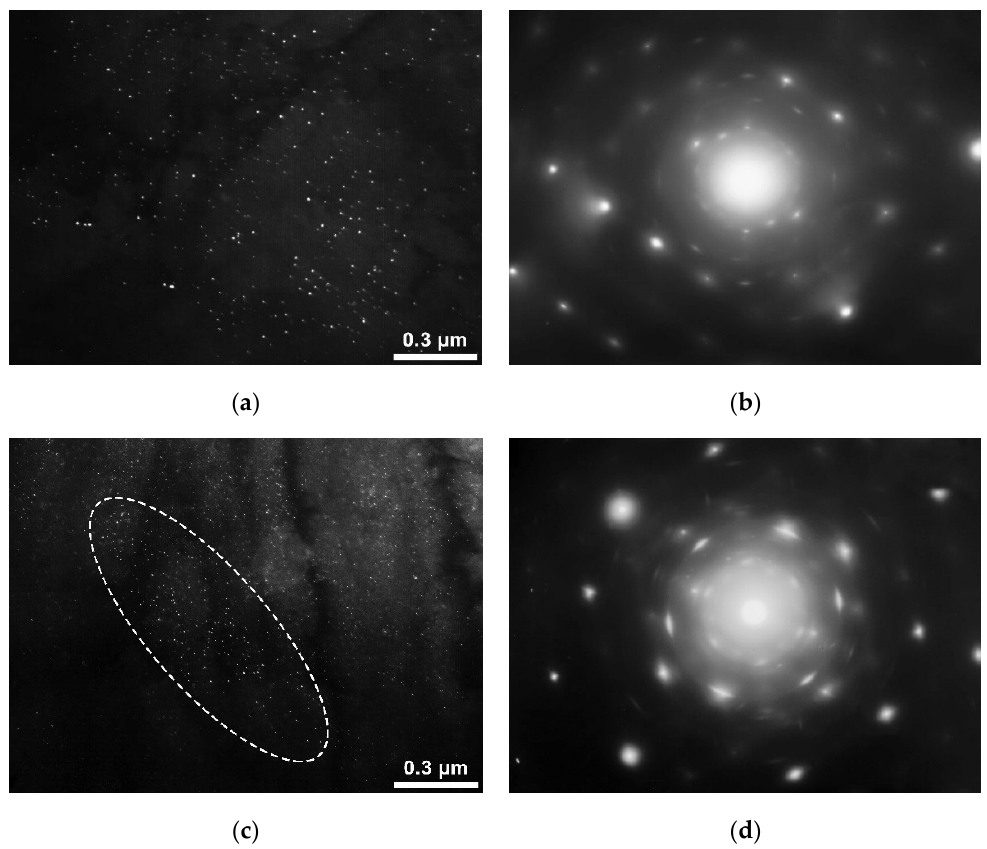
Figure 7. Dark-field image in reflections of nanosized carbonitrides (steel No 5): ( a ) Formed in austenite (advantage in the dedicated area); ( c ) Interphase; ( b , d ) Diffraction patterns to them. There are also submicron precipitates (Figure 8), their size is about 60–120 nm. Some of these are indicated by arrows in the figure. The shape of the largest precipitates is dendritic, of the relatively small, closer to equiaxial (strongly rounded dendrites).